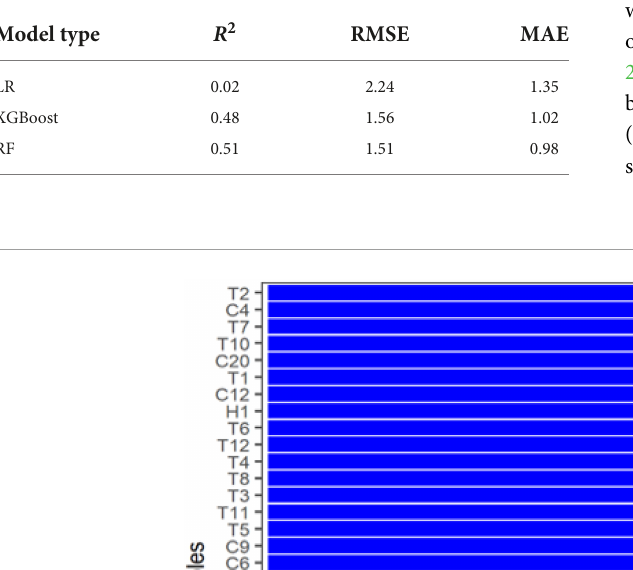
TABLE 2 Statistical comparison of random forests (RF) model, Linear Regression (LR), and XGBoost model to predict random forests using bioclimatic variables statistics characteristics show the coefficient of determination ( R 2 ), root means square error (RMSE), and mean absolute error (MAE).